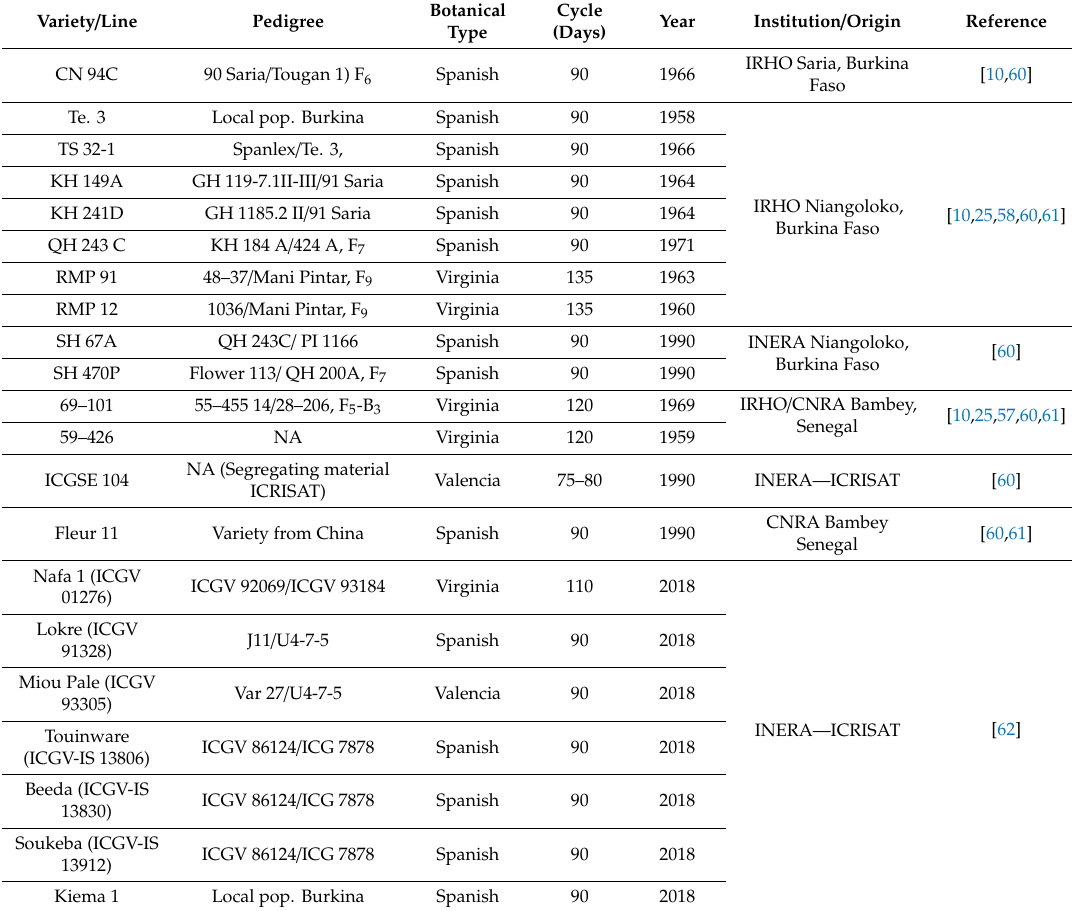
Table 1. Groundnut varieties released from the 1950s to date and registered in the national catalogue of plant